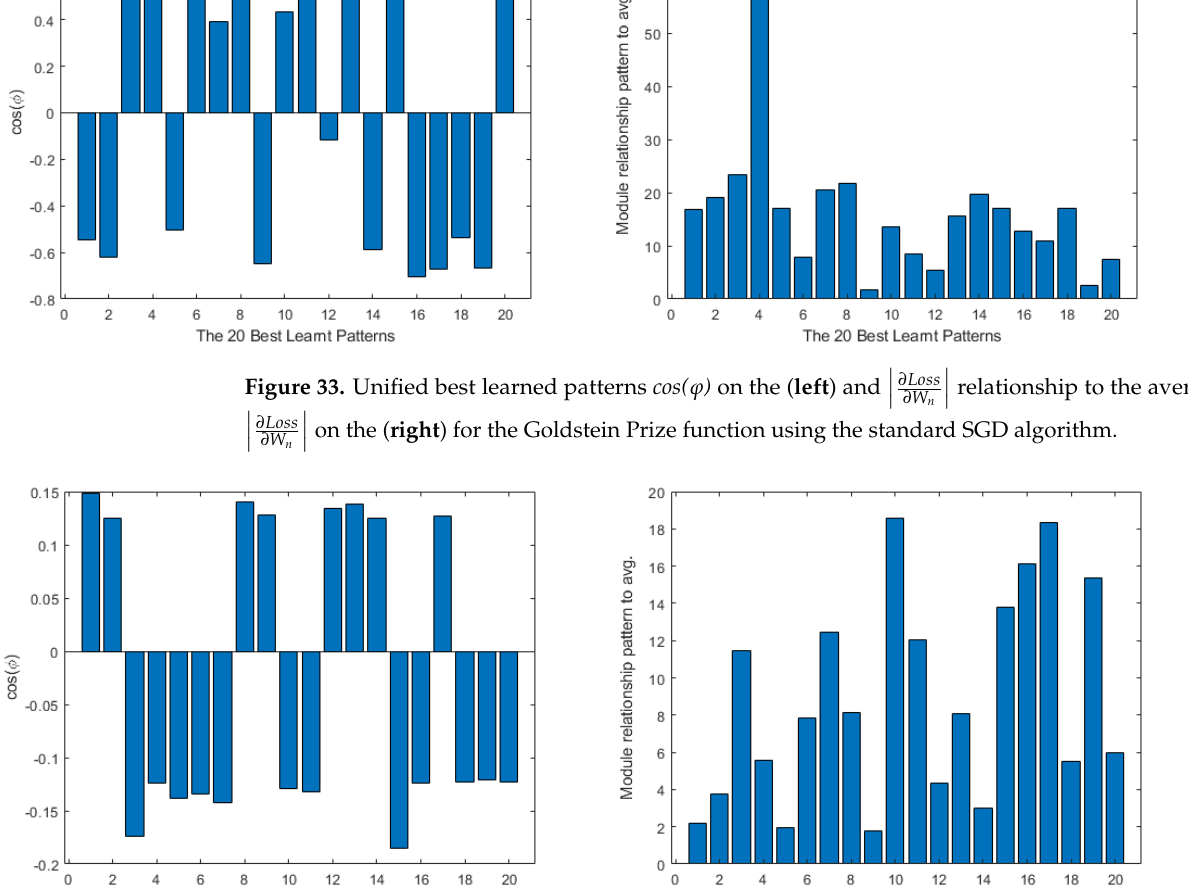
(cid:12) (cid:12) 𝜕𝐿𝑜𝑠𝑠 ∂ Loss (cid:12) (cid:12) | relationship to the average (cid:12) (cid:12) relationship to the average ∂ W n 𝜕𝑊 𝑛